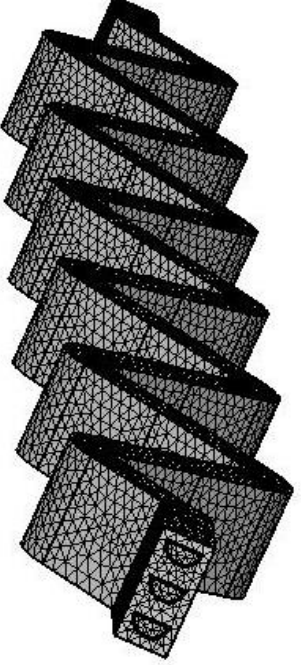
Figure 5. The schematic diagram of the grid model.